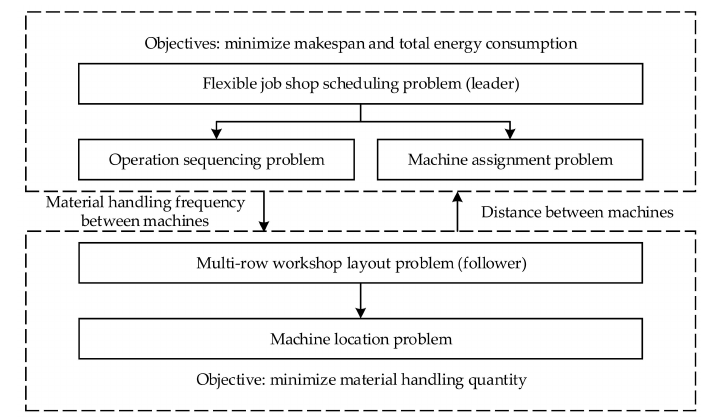
Figure 3. Leader-follower coordinated structure of the MEIFM